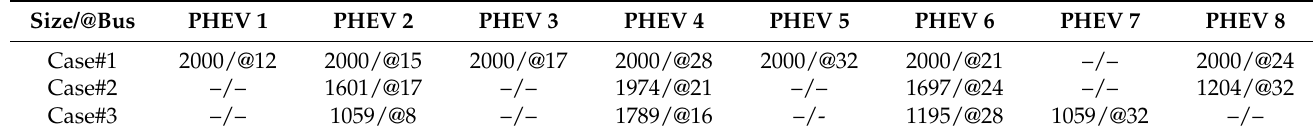
Table 3. Size and installation location of PHEVs in the 33-bus distribution network.